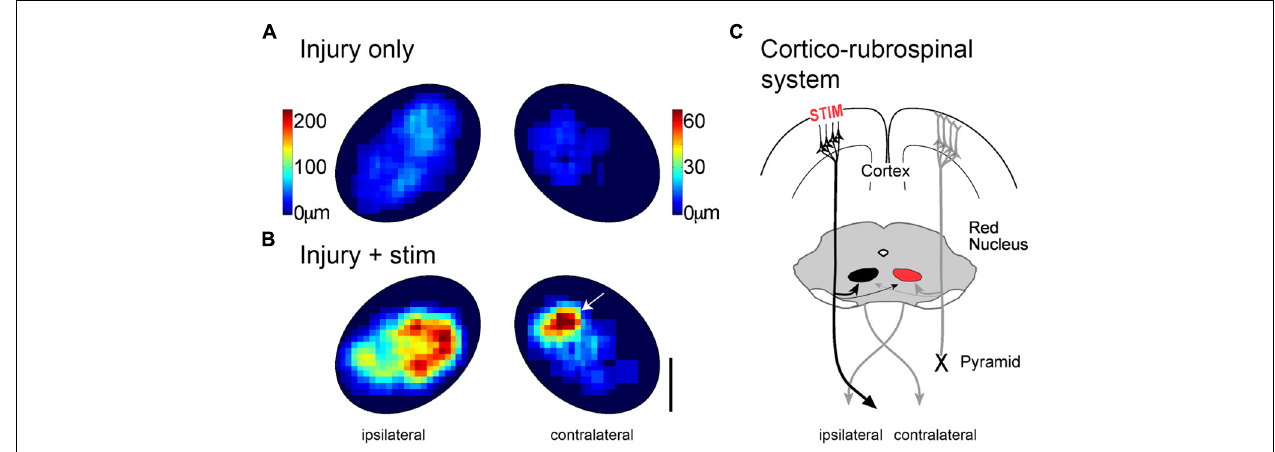
FIGURE 4 | Motor cortex stimulation causes robust outgrowth to the magnocellular red nucleus. Heatmaps showing corticorubral axon density in the magnocellular red nucleus after injury alone (A) and injury plus stimulation (B) . Color scales apply to both (A,B) . Note the axon length scales are different